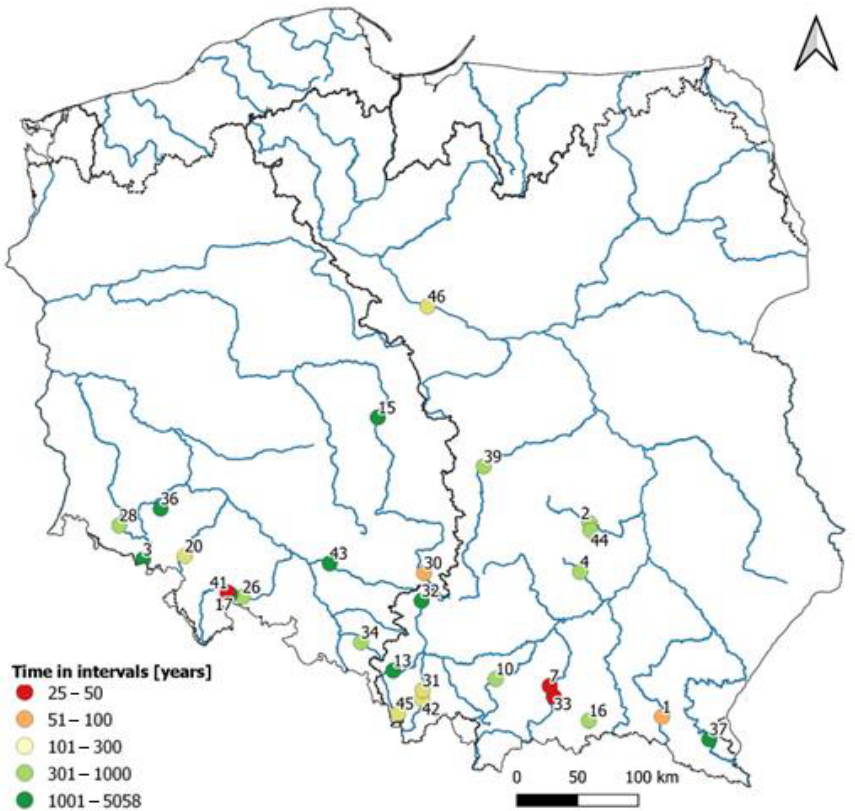
Figure 7. Forecast for the loss of capacity up to the value of 50% of the initial capacity of key reservoirs for water management in Poland, belonging to capacity change classes I to II. Reservoirs: 1.